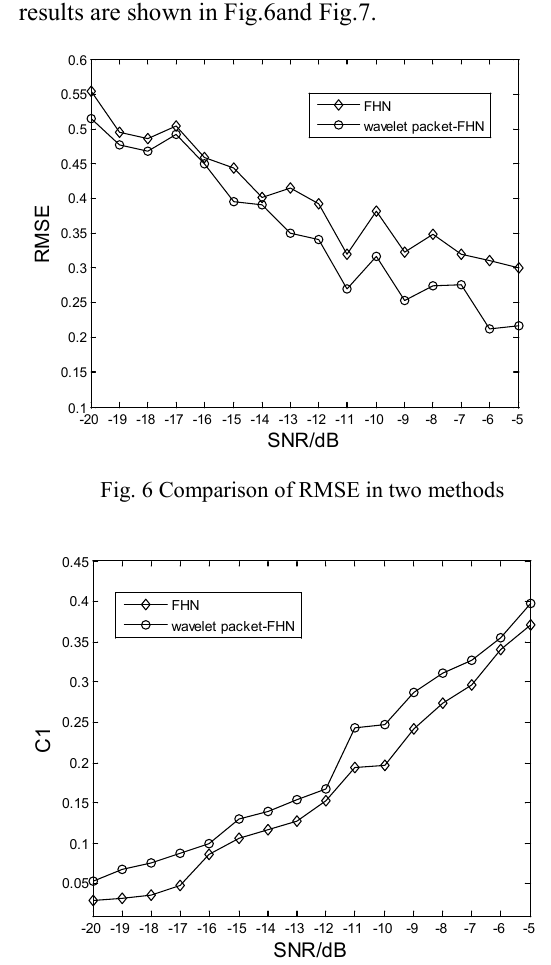
Fig. 7 Comparison of Input-output cross correlation in two